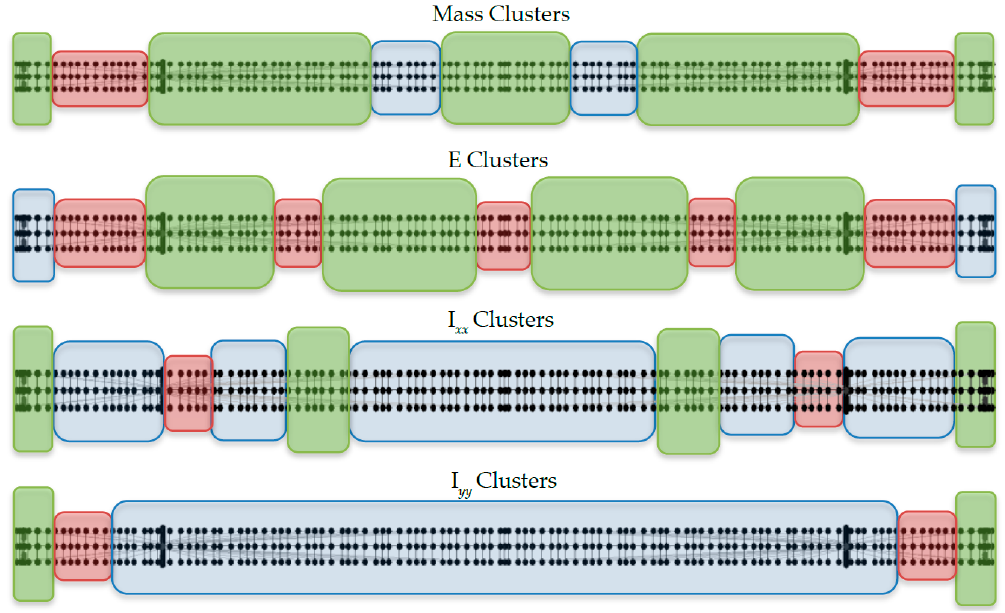
Figure 4. Cluster analysis result for four types of physical parameters for the bridge girder. Elements with the same color are from one cluster (blue box: cluster 1, green box: cluster 2, red box: cluster 3). Table 1. Uncertain components in the structural model parameter vectors for model class M 1 and M 2 . Model